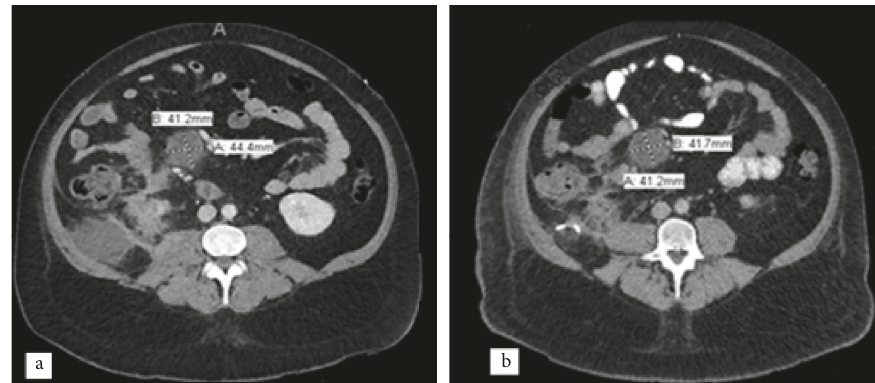
Figure 3: Computed tomography scan before starting antimicrobial therapy in Patient 3 shows a locule of complex fluid in the midline near the superior mesenteric vein measuring 4.4 × 4.1cm (a). Computed tomography at time of antimicrobial completion shows a persistent phlegmonous collection measuring 4.2 × 4.1cm (b).